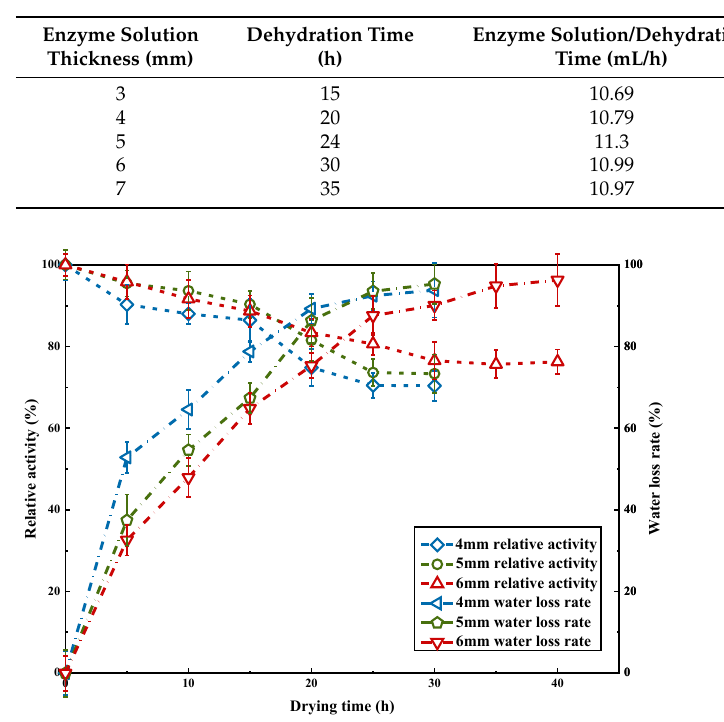
Figure 4. Effect of technological parameters including ( a ) pre-freeze temperature, ( b ) pre-freeze time and ( c ) trehalose concentration on κ -selenocarrageenase activity in freeze-drying process. Table 3. Relation between liquid thickness and Dehydration time.